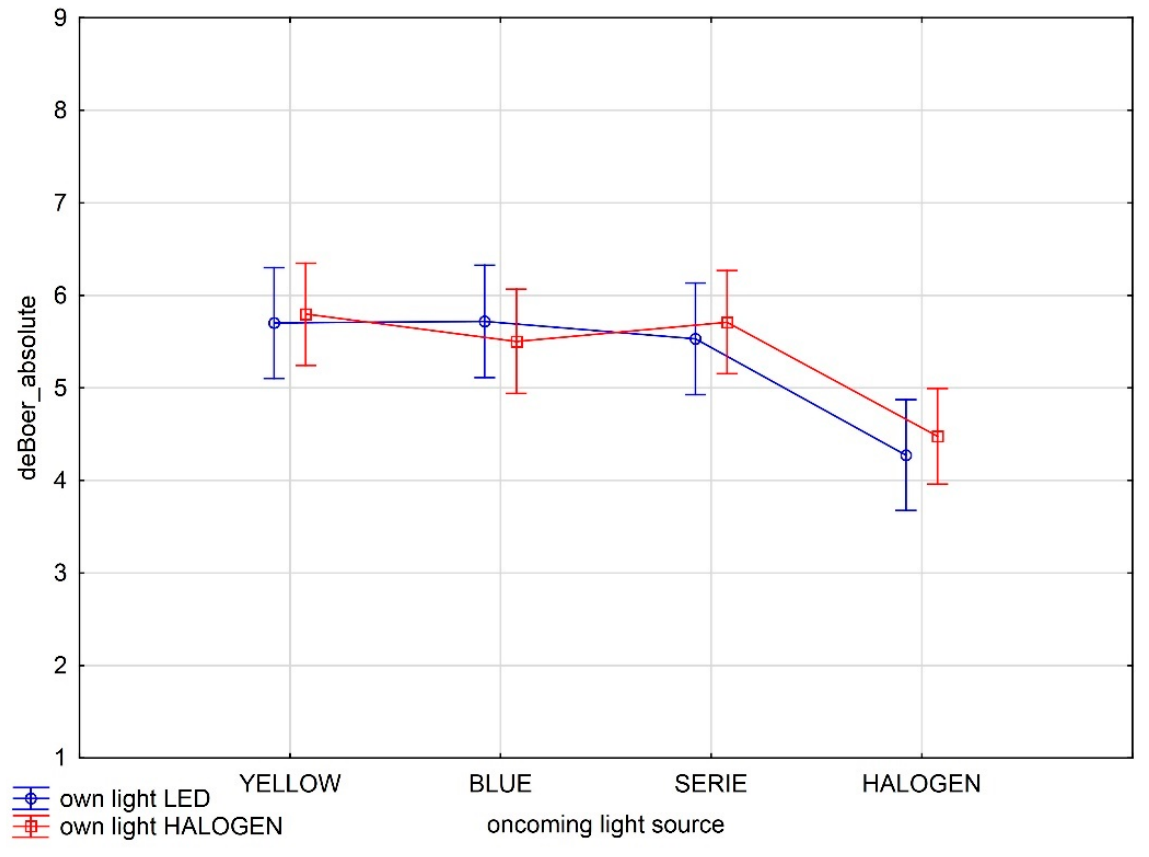
Figure 6. Relationship between the adapted de Boer scale ratings and the combination of the driver’s and the oncoming traffic’s